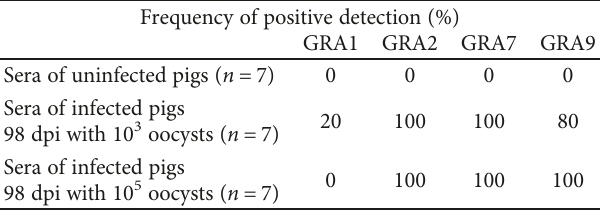
Table 1: Immunoreactivity of sera from T. gondii -infected pigs to di ff erent recombinant GRA antigens (GRA) based on Western blot analyses. Frequency of positive detection (%) GRA1 GRA2 GRA7